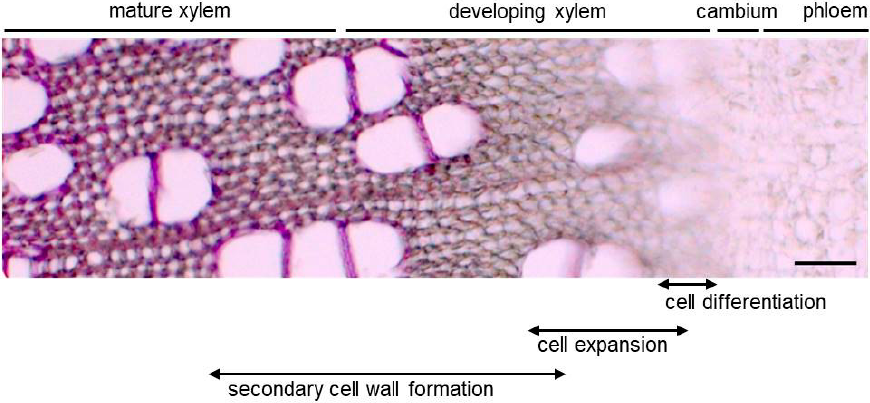
Figure 1. Cross-section of a 3 month old poplar stem illustrating the different steps of wood formation. Cross-section has been stained with Phloroglucinol/HCl. Purple color indicates lignification. Bar = 50 µm.